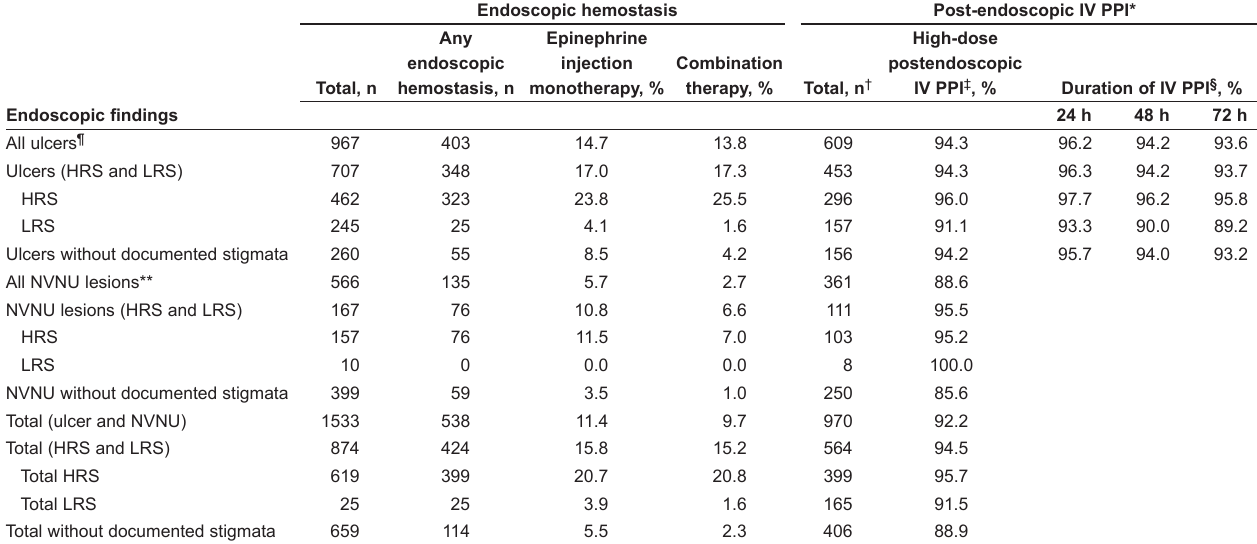
TAble 1 endoscopy and pharmacotherapy in ulcer and nonvariceal nonulcer upper gastrointestinal